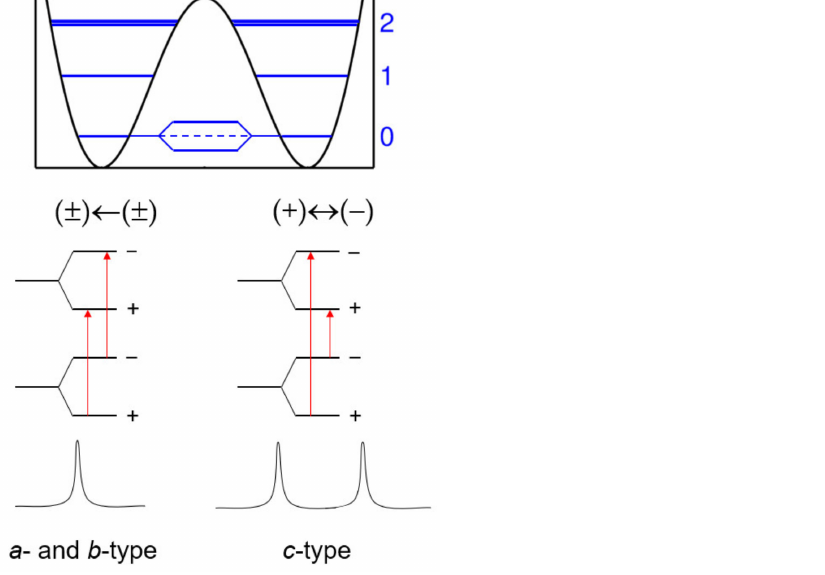
Figure 2. Schematic energy-level diagram illustrating the splittings caused by an inversion-tunneling motion where the µ c dipole-moment component changes its sign upon